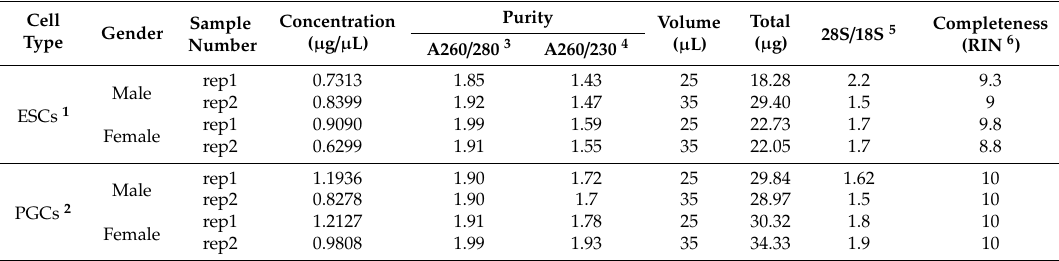
Table 1. The purity and competencies of